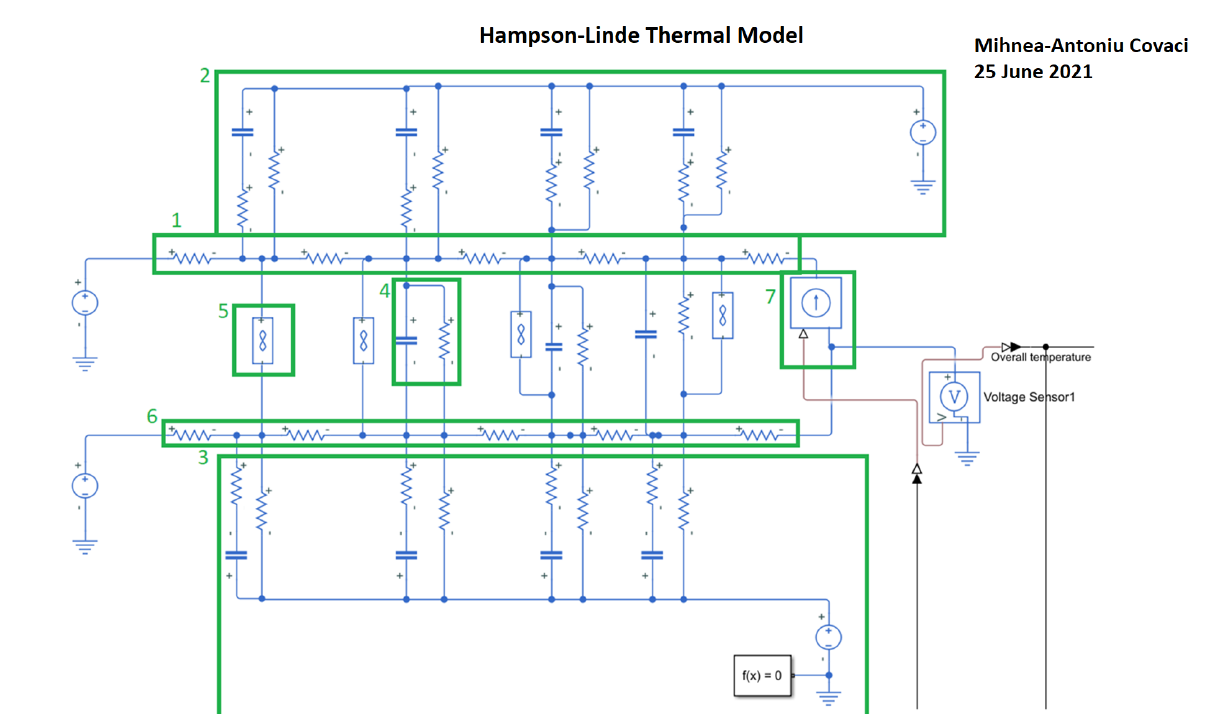
Figure 13. Hampson ‐ Linde process block diagram.